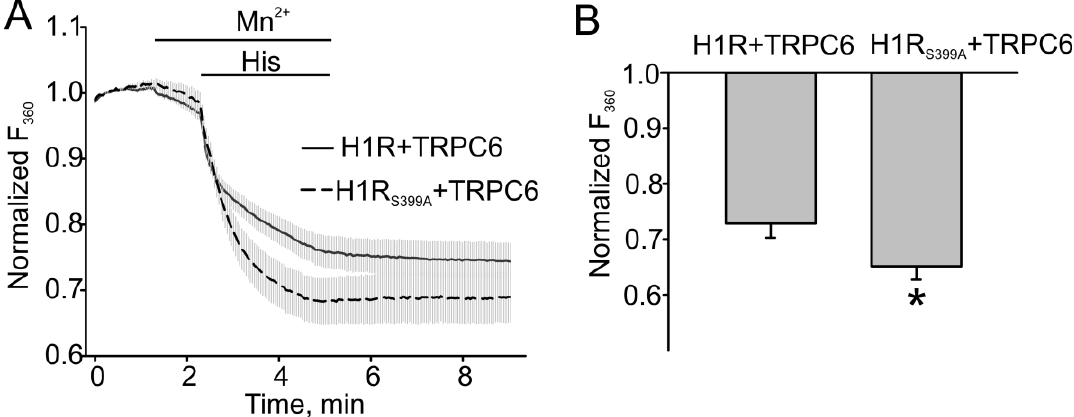
Figure 4. The H1 receptor mutant potentiated the TRPC6 channel activity in HEK model. ( A ) Mn 2+ (0.5 mM) influx in H1R/TRPC6 expressing HEK cells versus H1R expressing HEK cells, which were measured by the percent of Fura-2 quenching (Fura-2 was excited at 360 nm) at the time point of 5 min. ( B ) The summary data comparing the percent of Fura-2 quenching are shown. The bold and broken lines represent the averaged traces, and the vertical gray lines are the SEM values. Data in ( B ) are presented as mean ± S.E. Asterisk = p <